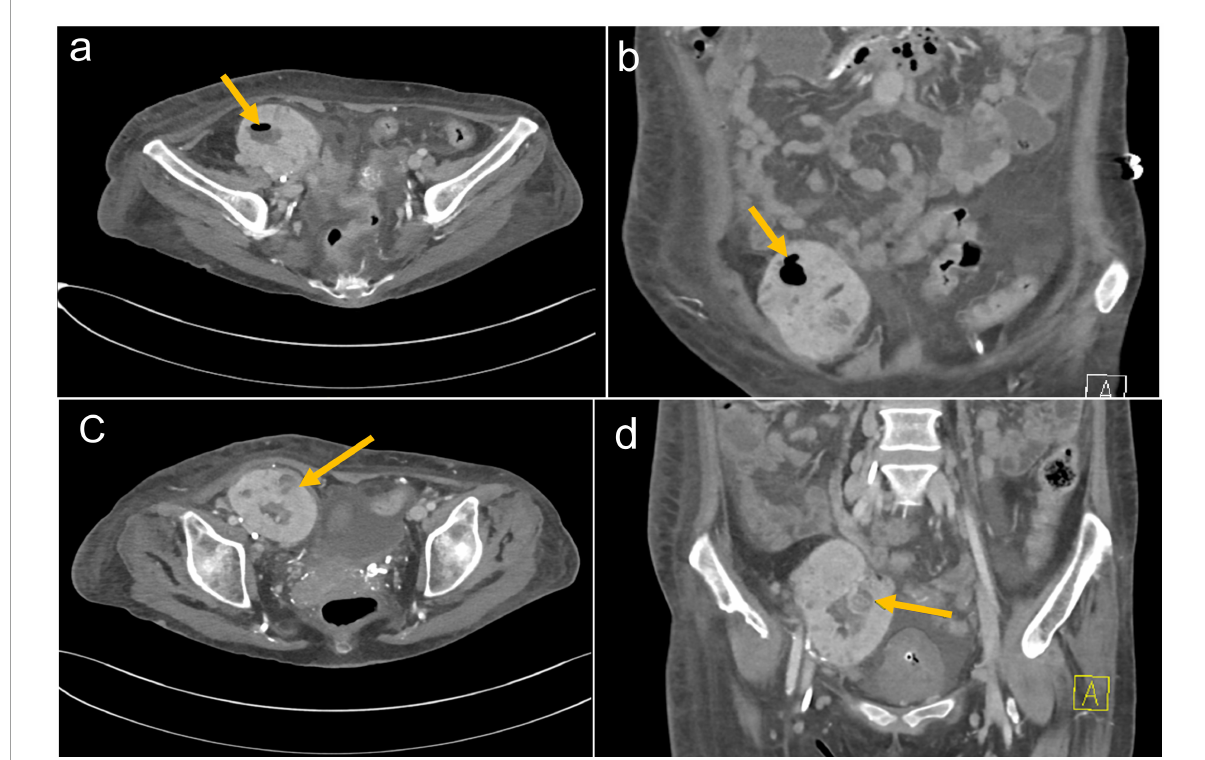
FIGURE2 (a) Axial and (b) coronal CT images of the abdomen demonstrating the right lower quadrant kidney transplant with air in the renal collecting system. (c) Axial and (d) coronal CT images of the abdomen demonstrating right lower quadrant kidney transplant with loss of cortico-medullary differentiation and developing a complex intraparenchymal fluid collection with adjacent soft tissue perinephric rind. There is debris throughout the collecting system.